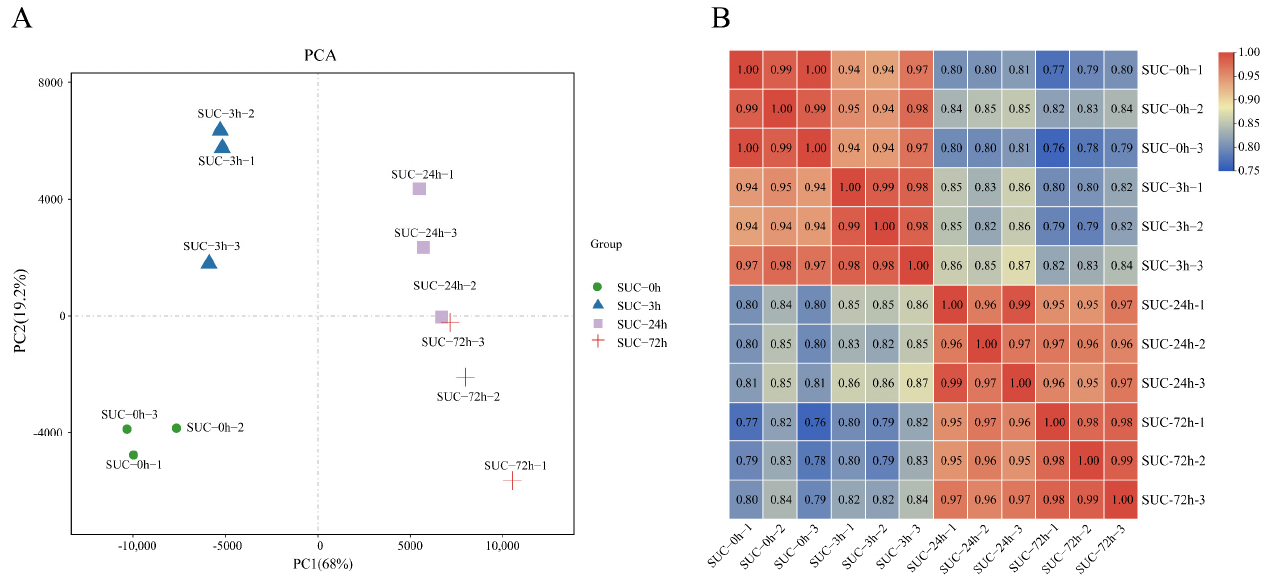
Figure 2 . Correlation analysis of samples under sucrose treatment at different time points. ( A ) Prin- cipal component analysis (PCA) of samples subjected to sucrose treatment at different time points. ( B ) Pearson’s correlation coefficient analysis of the 12 samples under sucrose treatment at indicated time points. The red scale indicates a high correlation, and the blue scale indicates a low correlation. Based on the RNA-seq data, genes with FDR ≤ 0.05 and |log2FC| ≥ 1 were identified